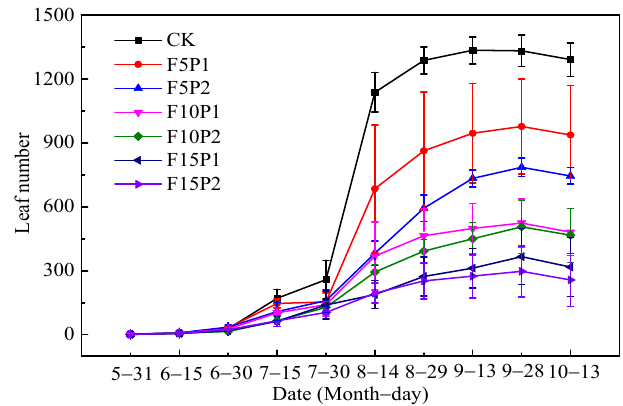
Figure 5. Effects of CSL on leaf number of Artemisia ordosica .